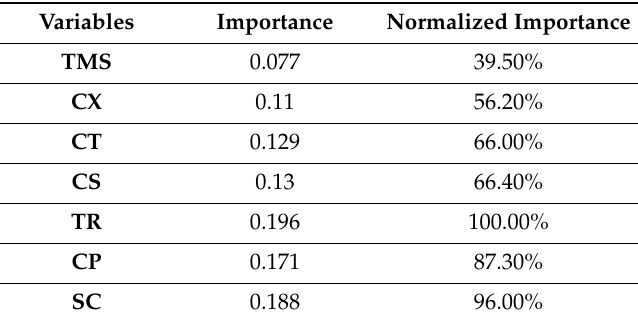
Table 9. Normalized importance of